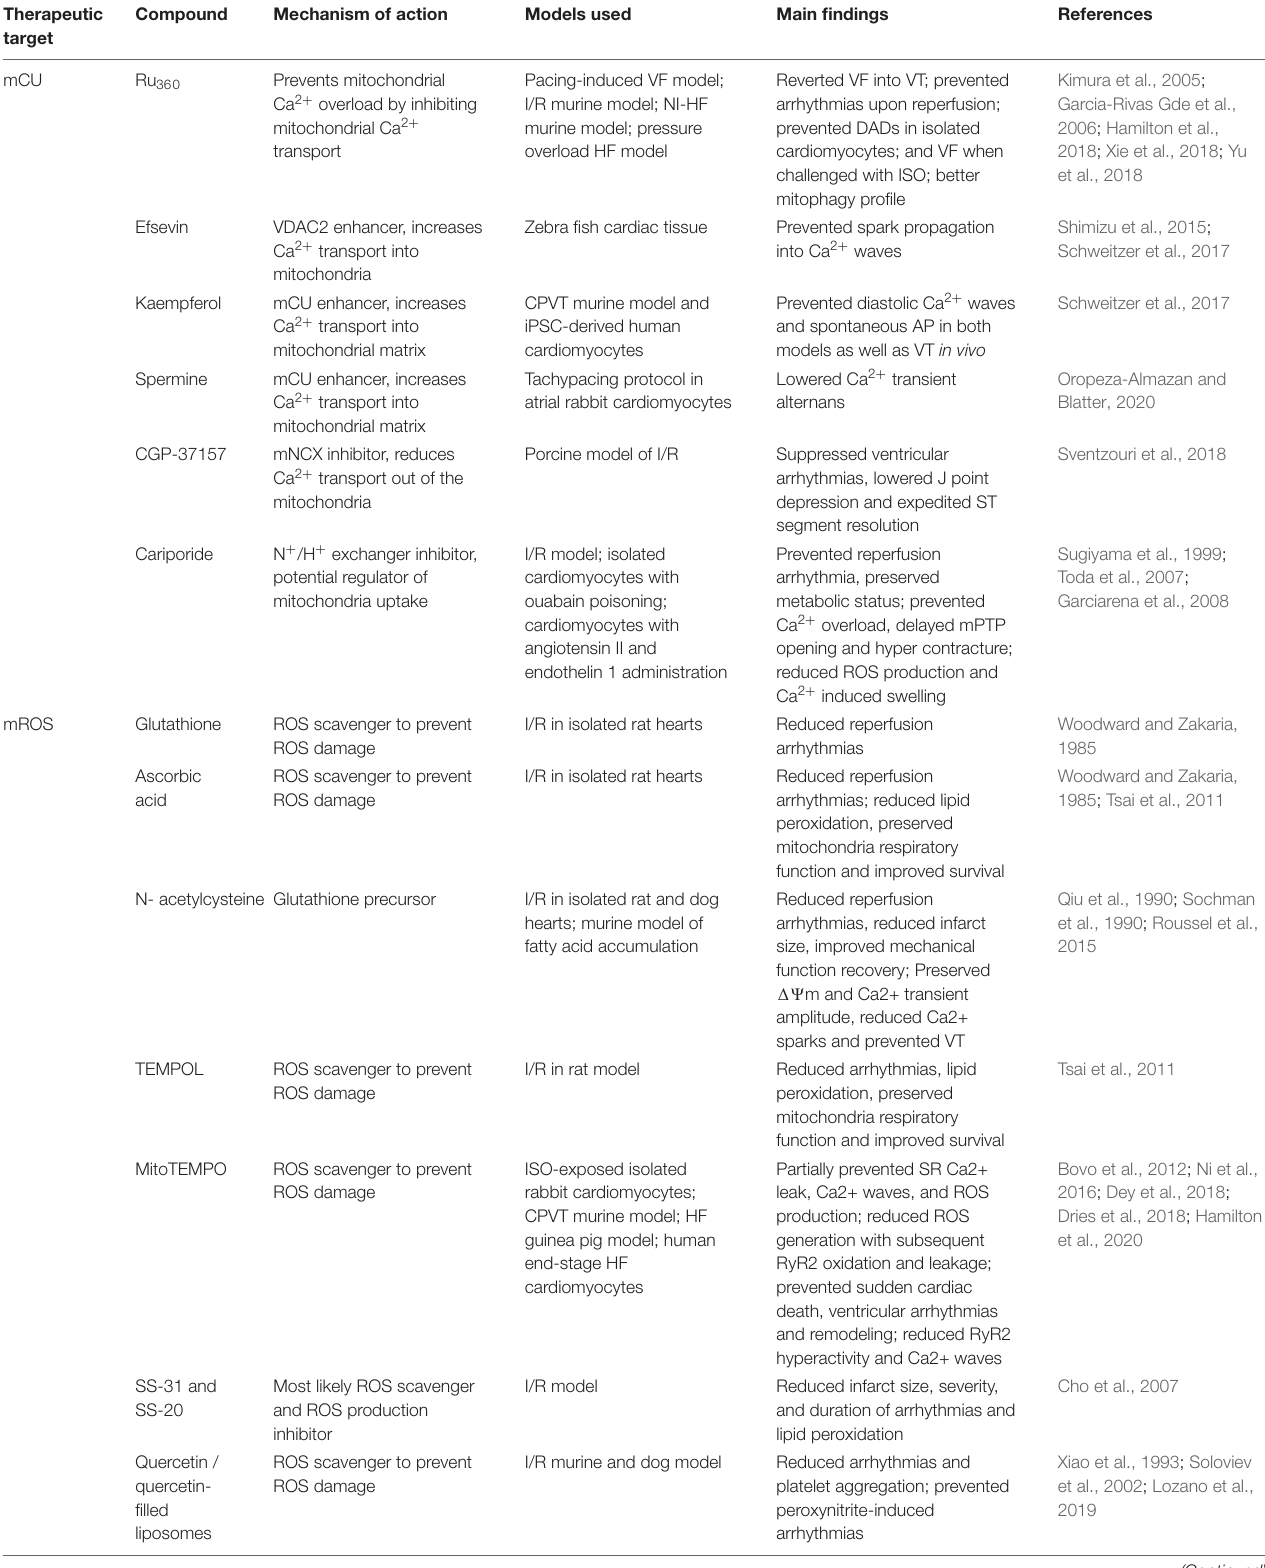
TABLE 1 | Summary of therapeutic strategies used to prevent arrhythmogenic events and their main